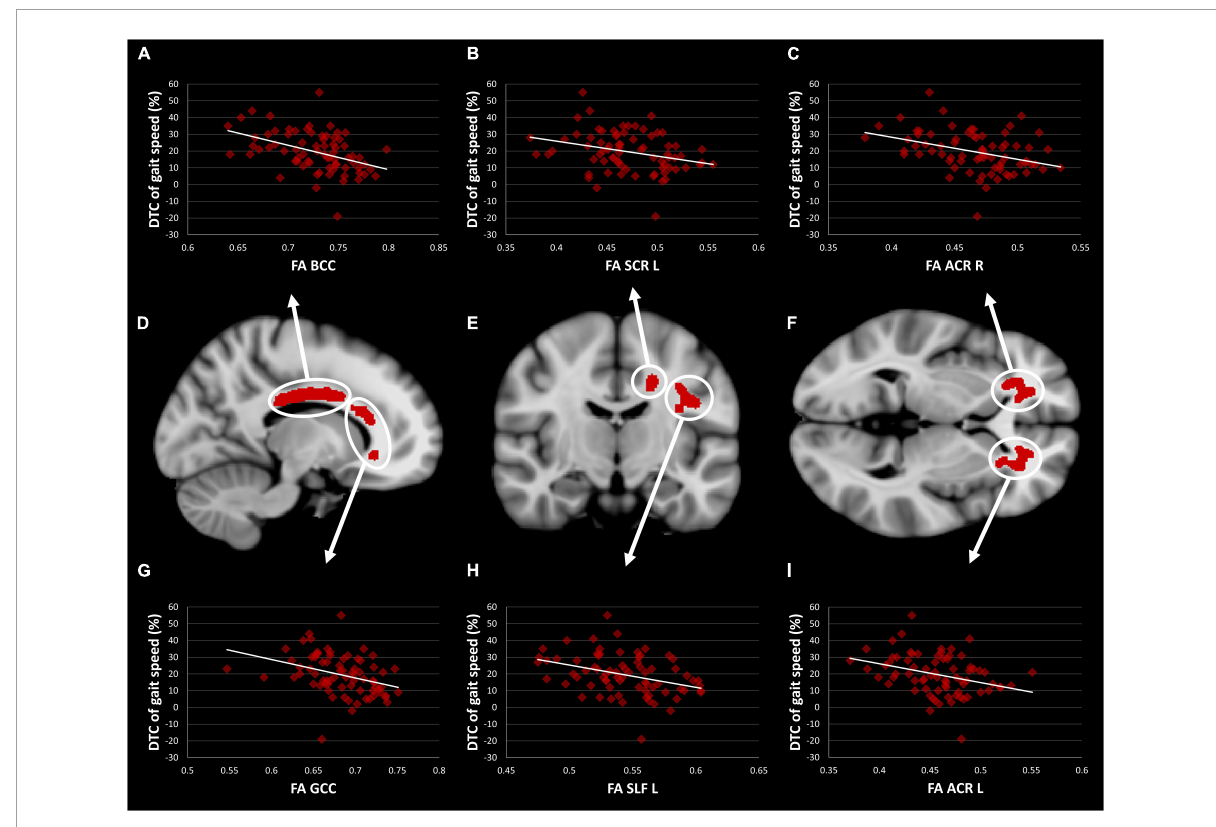
FIGURE2 TBSS Clusters with a significant correlation between DTC of gait speed while subtracting and FA (D–F) displayed on T1 MNI-152 template (1 mm). Scatter plots showing a correlation between FA and DTC of gait speed while subtracting in body (A) and genu (G) of the corpus callosum, left superior corona radiata (B) , left superior longitudinal fasciculus (H) , right (C) and left (I) anterior corona radiata. TBSS, tract-based spatial statistics; FA, fractional anisotropy; DTC, dual-task costs; GCC, genu of the corpus callosum; BCC, body of the corpus callosum; ACR, anterior corona radiata; SCR, superior corona radiata; SLF, superior longitudinal